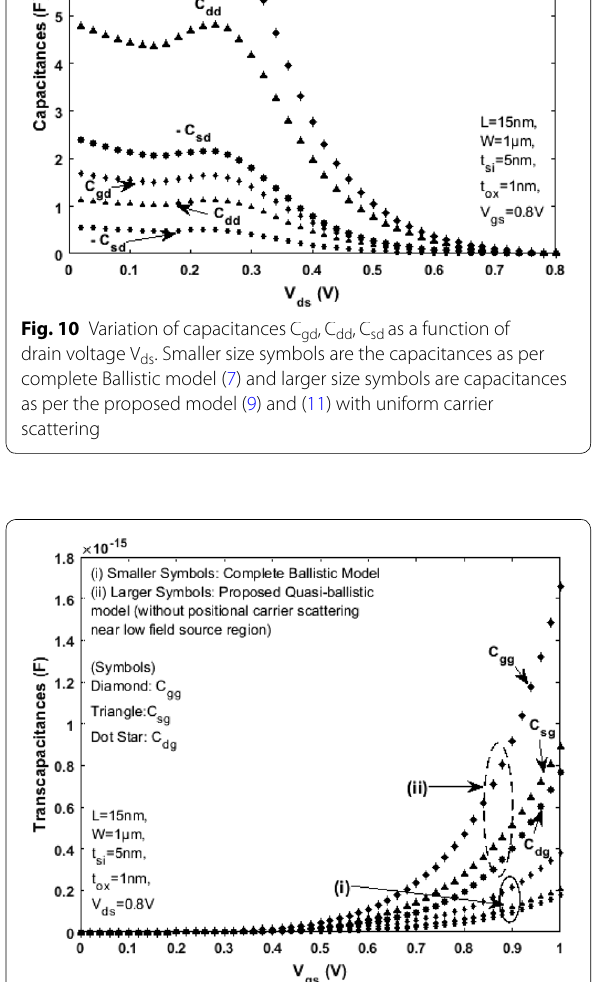
Fig. 11 Variation of Transcapacitances C gg , C sg , C dg as a function of gate voltage V gs . Smaller size symbols (i) are the capacitances as per complete Ballistic model (7) and larger size symbols (ii) are capacitances as per the proposed model (9) and (11) with uniform carrier